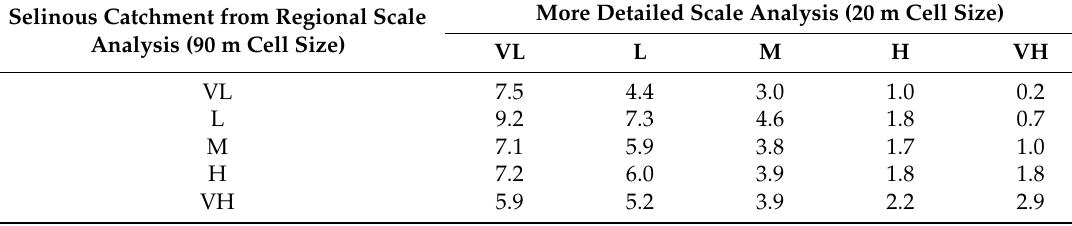
Table 4. Coverage percentage (%)-based cross-comparisons for the landslide susceptibility (LS) categories between the Selinous catchment from the regional scale analysis and more detailed scale analysis.